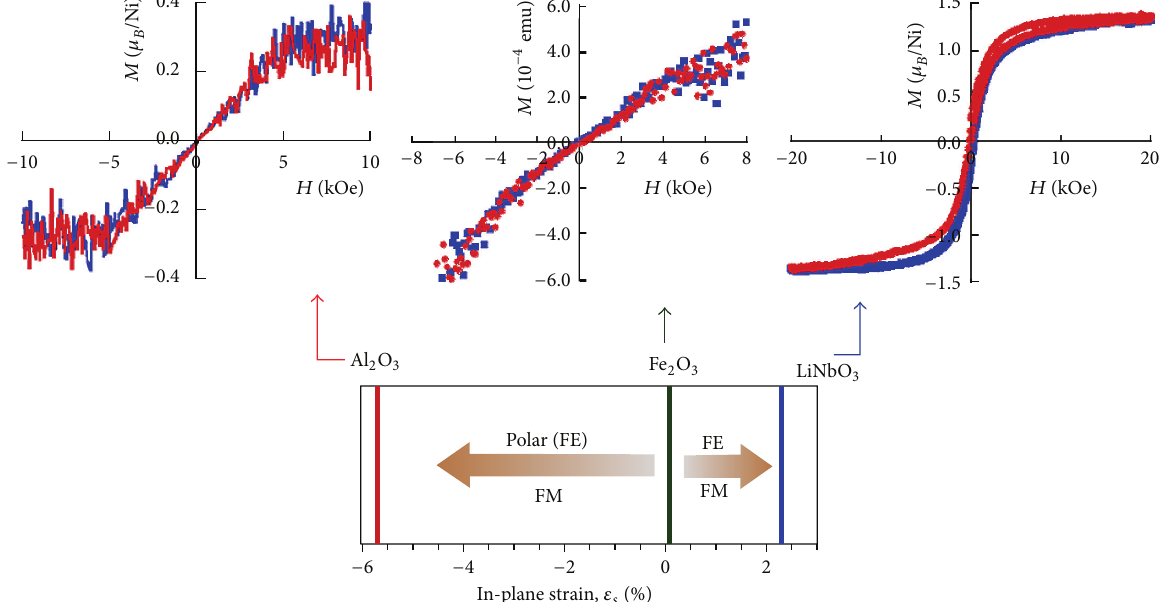
Figure 4: (Color online) Field-dependent magnetization curves correlated with the schematic strain diagram showing the % amount of mismatch exhibited by the three substrates Al 2 O 3 , Fe 2 O 3 , and LiNbO 3 , in the in-plane direction: magnetization curves for epitaxial NiTiO 3 /Al 2 O 3 film at 10K, below the N´eel temperature indicating residual magnetization, for epitaxial NiTiO 3 /Fe 2 O 3 film at 50K showing no ferromagnetism, and for epitaxial NiTiO 3 /LiNbO 3 film at 90 K showing